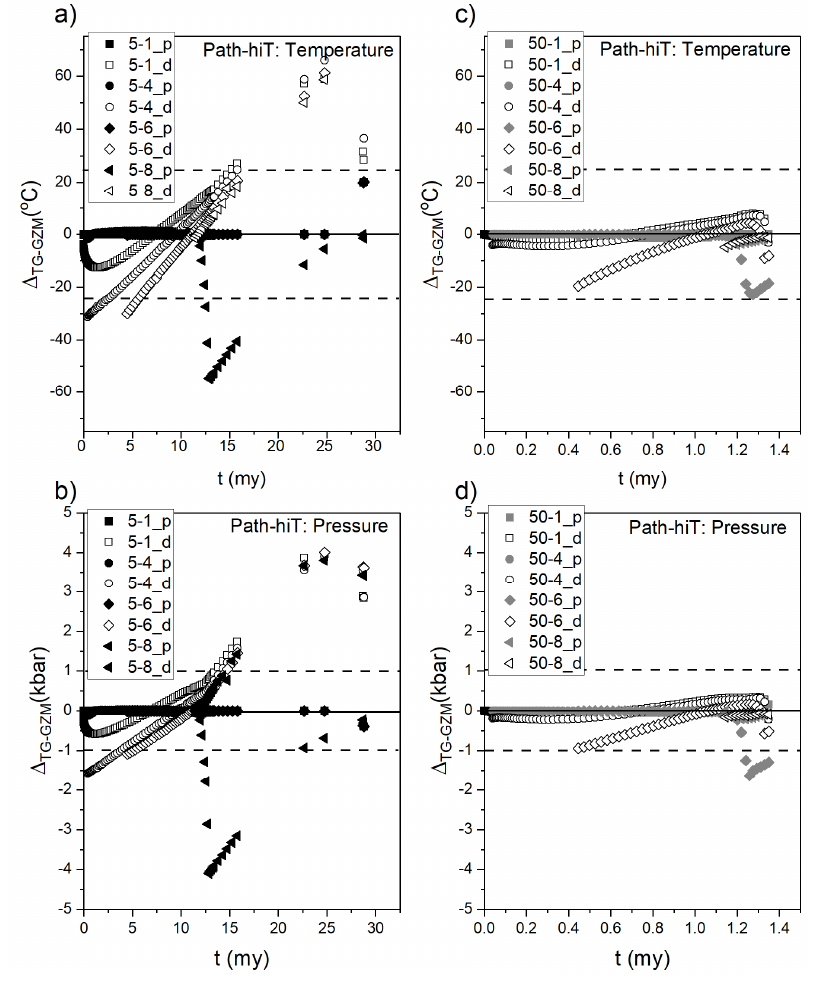
Figure 10. A visual representation of the computed mismatch between the prescribed path and GZM modeled path values for path hiT only ( Δ TG-GZM ). The x-axis represents the time from nucleation of radii class 1 (my = million years). ( a ) Temperature mismatch for path hiT-5. ( b ) Pressure mismatch for path hiT_5. ( c ) Temperature mismatch for path hiT_50. Pressure mismatch path hiT_50. ( d ) Pressure mismatch for path hiT_50.Dashed lines in every panel represent bounds of uncertainly for temperature ( ± 25 ◦ C) and pressure ( ± 1 kbar). Symbology code: 5-1_p = 5 ◦ C/my, class 1 primary composition; 5-1_d = 5 ◦ C/my, class 1 diffused